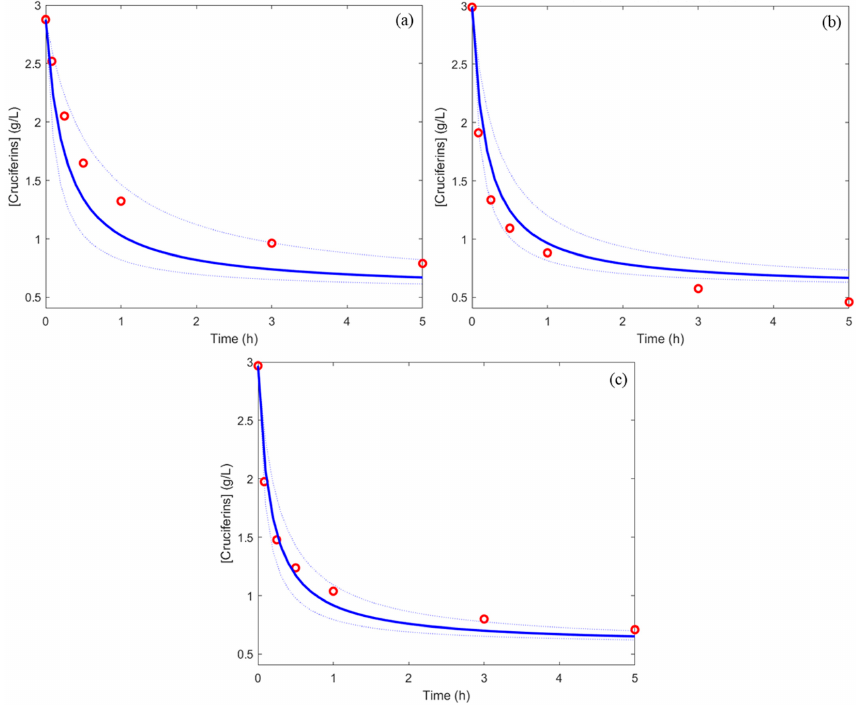
Figure 4. Experimental concentration (red points) and predicted concentration (blue line) with 95% predicted intervals (blue pointed line) for three different validation experiments ( a – c ). From the obtained model, Equations (10) and (11), the napin purity and yield were predicted for the three sets of conditions and compared to experimental values. Figure 5 shows the experimental versus predicted values of these two criteria. The results exposed good prediction of these criteria with R² between 0.85 and 0.99 for all validations points, which validated the applicability of the methodology and the model thus obtained in the case of selective hydrolysis of RPI with Prolyve ® enzyme.